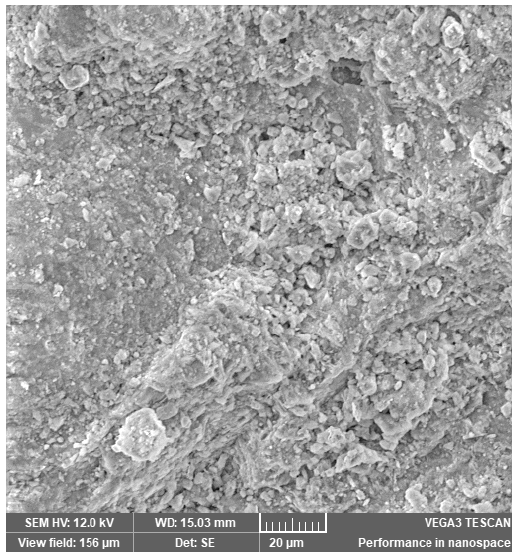
Figure 7. The SEM analysis of the zeolite sample HCl 1.